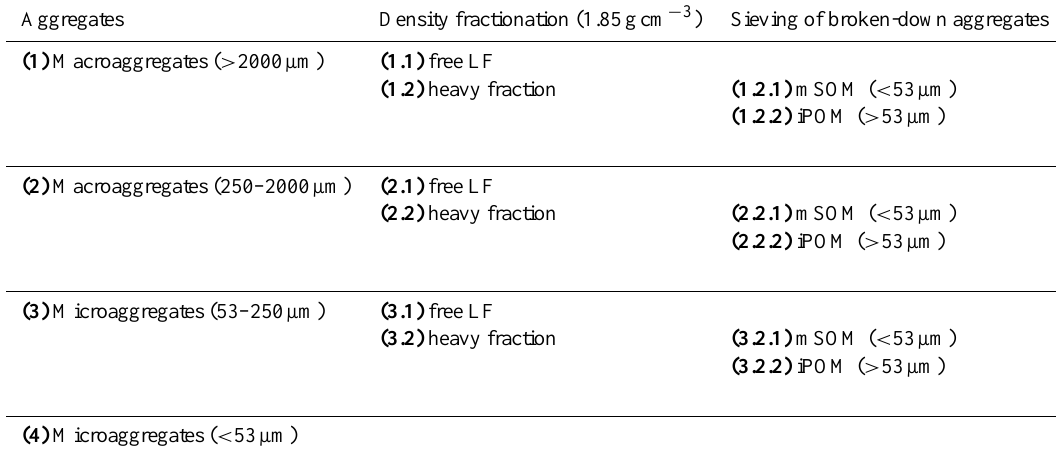
Table 1. The physical soil fraction obtained from a trallgrass prairie after nine years of warming and clipping. Soil fractions analyzed for C, N concentrations, δ 13 C, and δ 15 N are denoted by bold